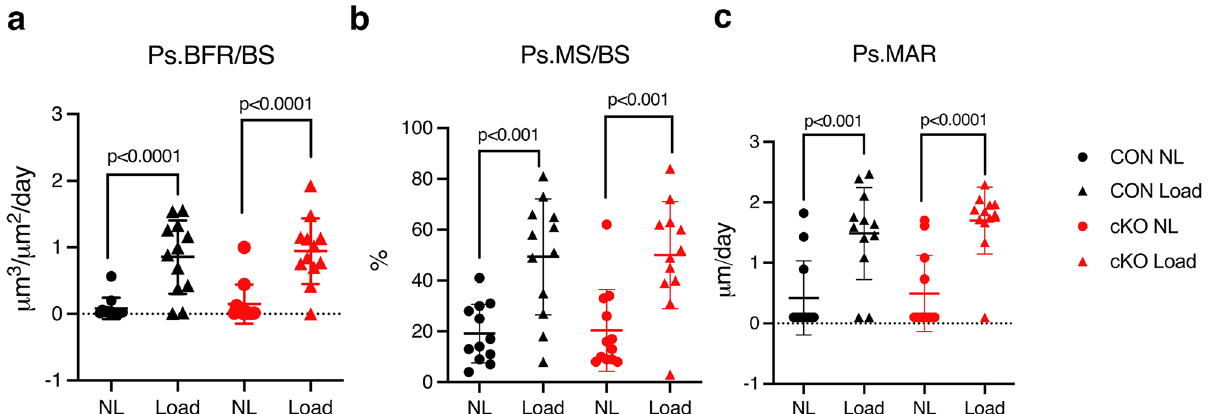
Figure 2. IKKα cKO mice have a similar response to anabolic loading compared to control. Anabolic response to unilateral axial tibial compression was assessed by dynamic histomorphometry, measuring parameters along the periosteum (Ps) after 2 wks. ( a ) Bone formation rate per bone surface (Ps.BFR/BS), ( b ) Mineralizing surface per bone surface (Ps.MS/BS), and ( c ) Mineral apposition rate (Ps.MAR). CON = black, cKO = red, all male mice. Right tibiae were loaded (Load, triangles) and left tibiae served as non-loaded (NL, circles) controls. Results are presented as mean ± SD. n = 12 per genotype. 2-way ANOVA followed by Tukey’s multiple comparison test; response to load within genotypes. There were no significant differences between genotypes, or interactions between genotype and